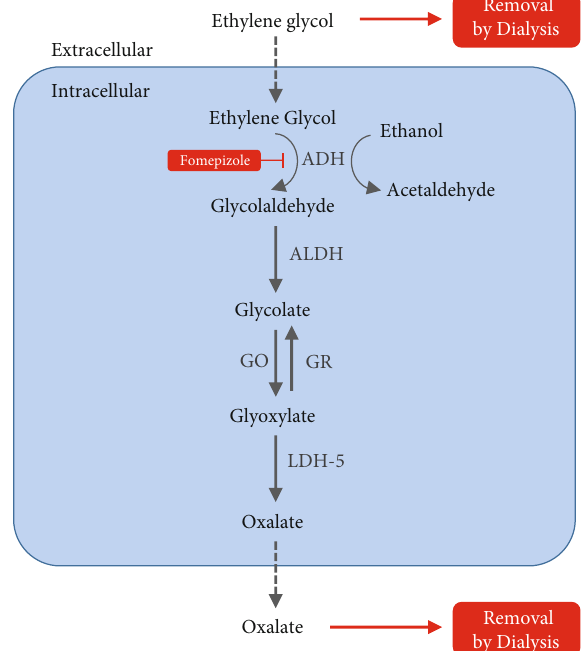
Figure 1: Ethylene glycol is metabolized via ADH to glycolaldehyde. Fomepizole and ethanol are competitive antagonists of ADH. The metabolic pathway leading from ethylene glycol to oxalate is